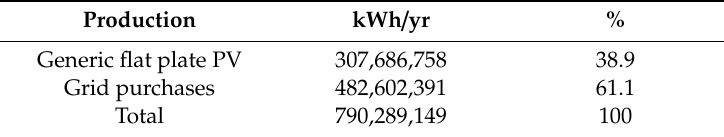
Table 5. Optimal system electricity production,